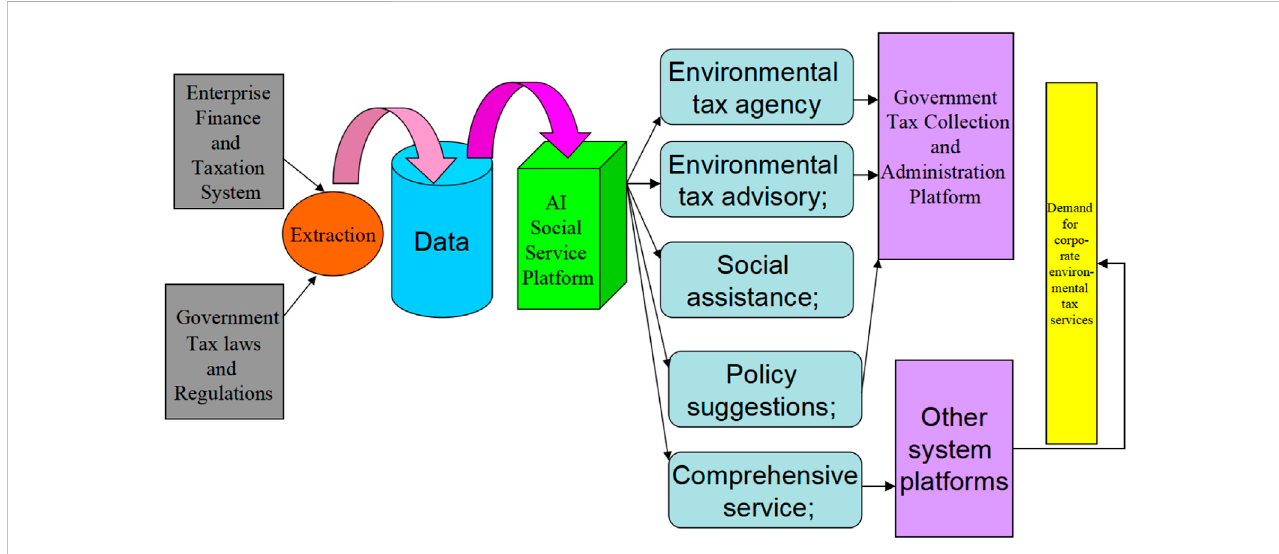
FIGURE 5 AI and environmental protection tax payment services.